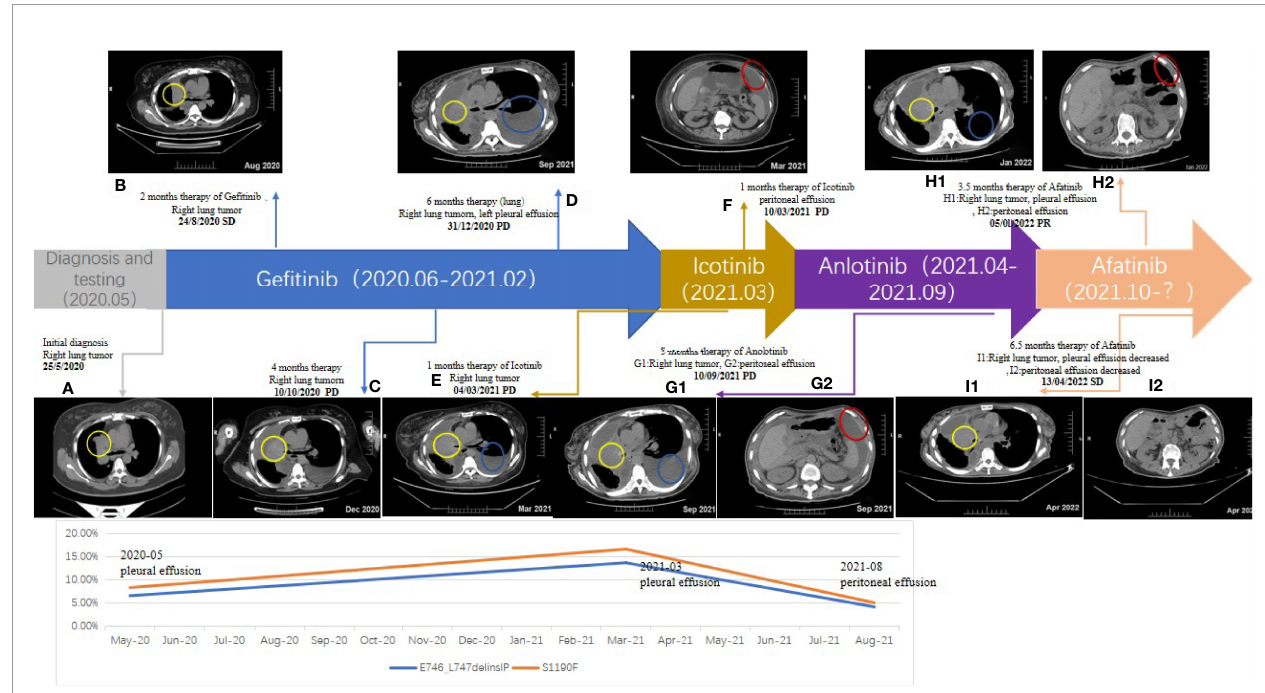
FIGURE 1 | Timeline of the patient: Chest and Abdominal contrast-enhanced CT (A – F, G1, G2, H1, H2, I1, I2) ; yellow circle: right lung tumor; blue circle: left pleural effusion; red circle: peritoneal